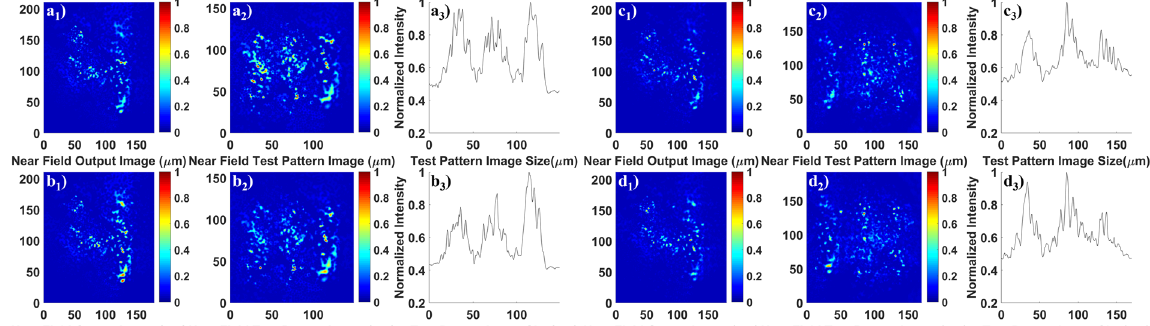
Figure 4. Images of numbers, line elements and the corresponding intensity profiles of the line elements after transport through 90 cm of GARF(1). ( a1 – a3 ) and ( c1 – c3 ) are the results obtained keeping the GARF(1) straight; while ( b1 – b3 ) and ( d1 – d3 ) are obtained using the same 90 cm long GARF(1) sample with a 180 degree turn (20 cm bending radius). The illumination wavelength for (a1–a3) and (b1–b3) is 405 nm, and the wavelength for ( c1 – c3 ) and ( d1–d3 ) is 635 nm. The number “4” belongs to group 3 on the resolution target. The line elements in ( a2 ) and ( b2 ) belong to group 4 number 5 on the resolution test target. The line elements in ( c2 ) and ( d2 ) belong to group 4 number 3. The visibility values are 0.35 for ( a3 ), 0.33 for ( b3 ), 0.26 for ( c3 ), and 0.31 for ( d3 ), respectively.